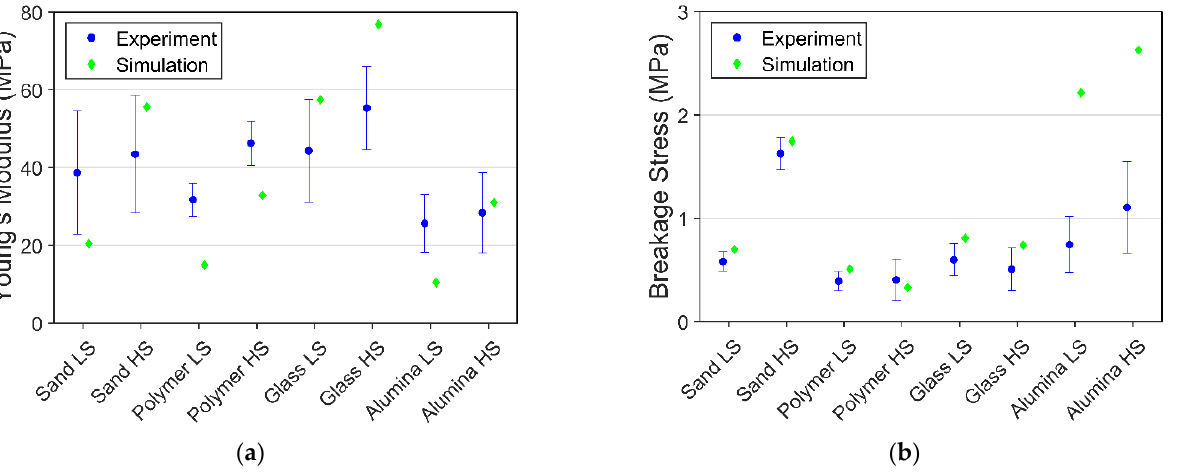
Figure 12. Comparison of experimental and simulation results for 75% saturation at −1 0 °C: ( a ) Young’s modulus; ( b ) Breakage stress.